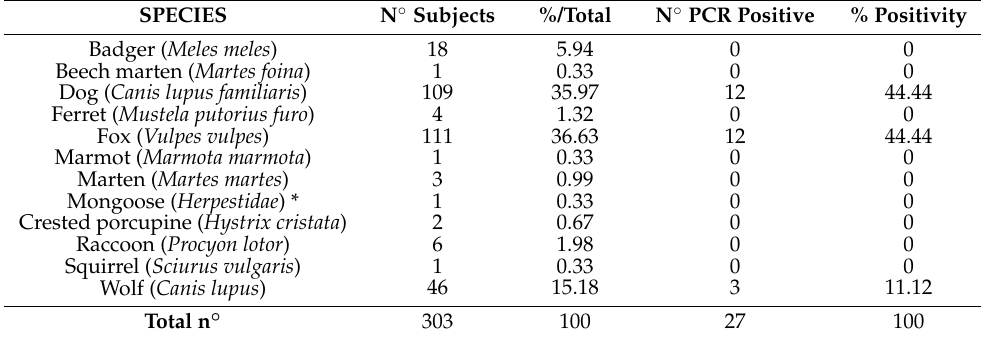
Table 1. Distribution of positive subjects by species, collected between 2011 and 2019.